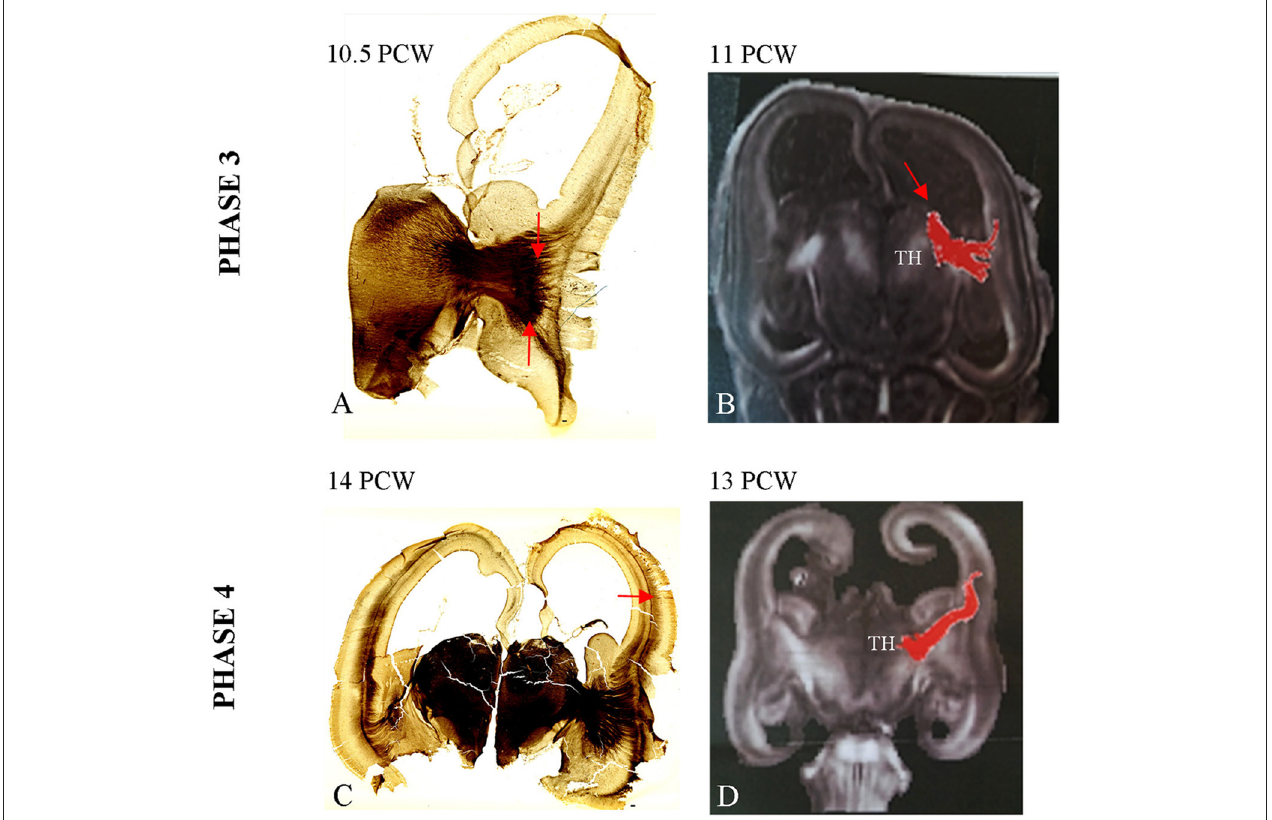
FIGURE 3 | Strongly stained radiating TH-C bundle (between arrows, A) approaching the pallium beyond the pallial-subpallial boundary. The DTI image of 11 PCW (B) shows DTI reconstruction of the TH-C bundle corresponding to the histological section from (A) . (C) The AChE reactive fibers originated from thalamus and basal forebrain enter the deepest portion of loose deep CP at 14 PCW (arrow). See also data from Duque et al. (2016). (D) Shows DTI image of extension of TH-C fibers directed to deep portion of CP at 13 PCW. Scale bar: 100 µ m.